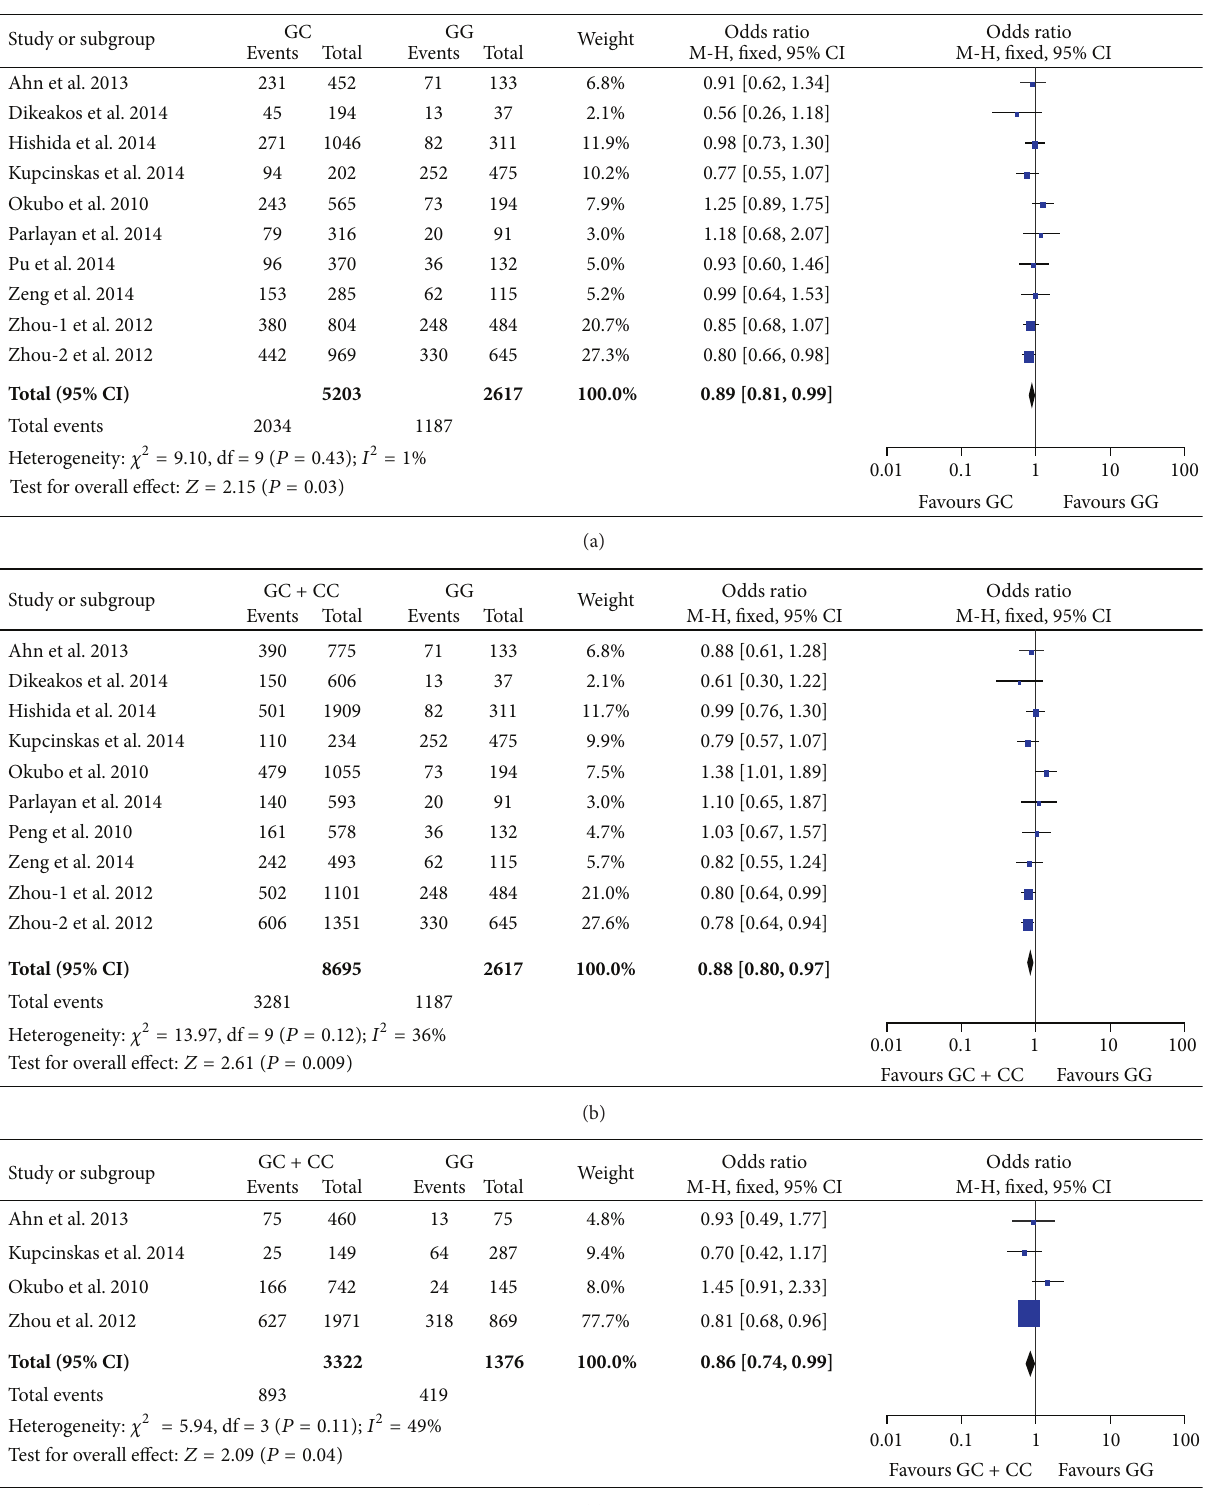
Figure 2: Forest plots of meta-analyses on rs2910164 in miR-146a. (a) Meta-analysis comparing heterozygous GC with GG. (b) Meta-analysis under dominant model (GC + CC versus GG). (c) Subgroup analysis in diffuse type gastric cancer using dominant model (GC + CC versus GG). The blue squares and corresponding horizontal lines indicate odds ratio of individual study. The area of the squares reflects weight of indicated study. The black filled diamond represents pooled odds ratio and 95% confidence